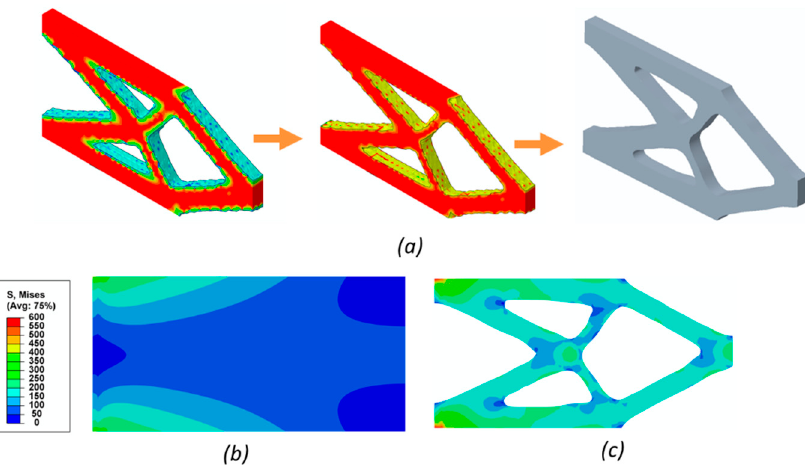
Figure 5. ( a ) Domain simplification methodology by using the output from topology optimization, thresholding the mesh to a user-specified partial density, designing a simplified CAD geometry using splines for introduction of lattices. ( bottom ) Static analysis plot shown the von Mises stress for ( b ) the original design domain and ( c ) the topology optimized output.